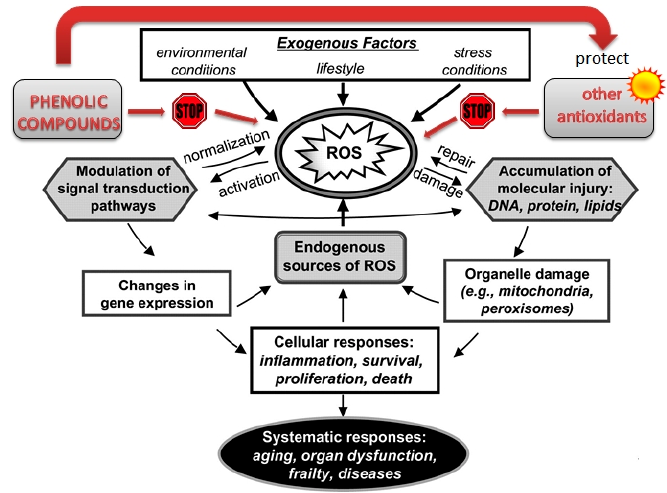
Figure 3. The scheme of factors involved in the formation of free radicals and a cellular response to reactive oxygen species (ROS). The red arrow and the text in red emphasize the importance of phenolic compounds, other antioxidants and the relationship between them. The sun signifies protection of other antioxidants by phenolic compounds.